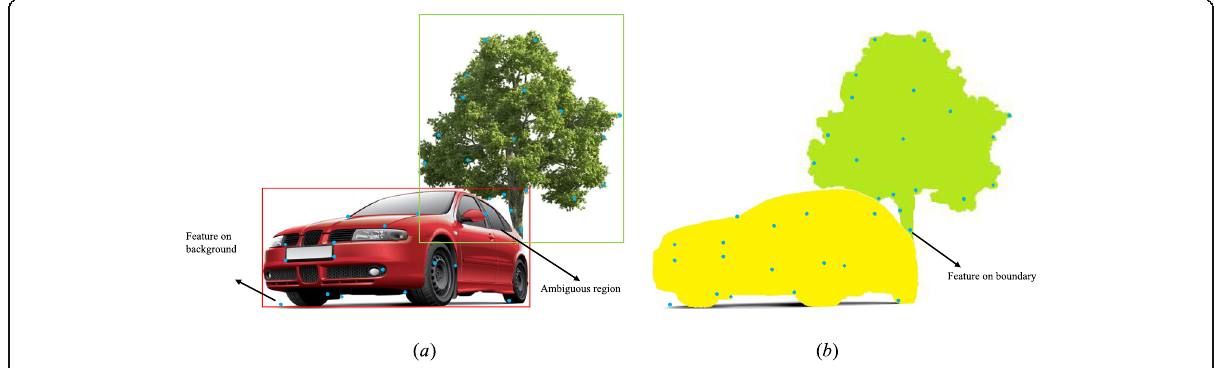
Fig. 4 Two ways to perform multi-motion segmentation using semantic information: ( a ) Assigning semantic labels with bounding boxes and ( b ) assigning semantic labels with pixel-wise semantic